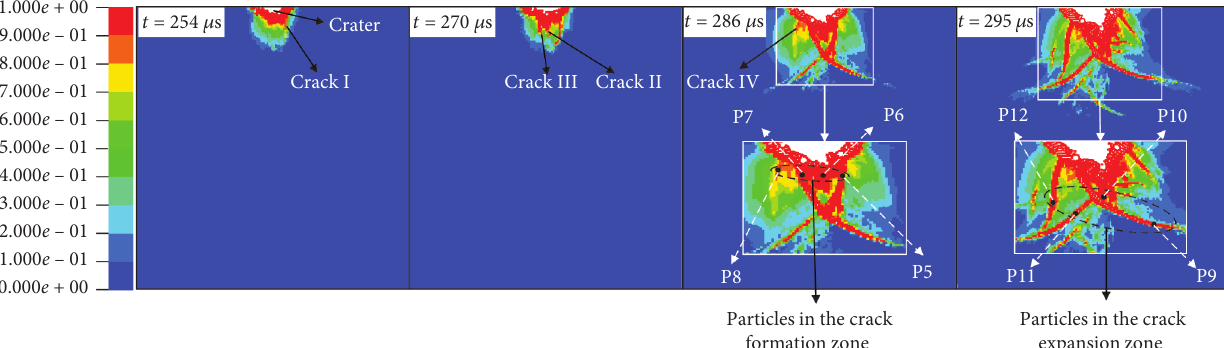
Figure 8: The formation and expansion process of